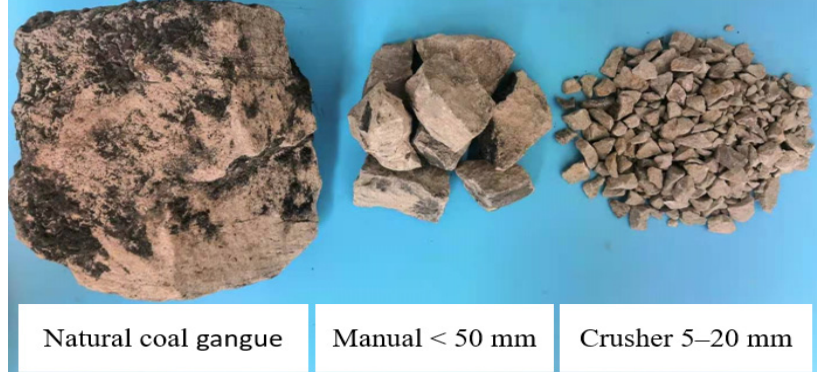
Figure 2. The production process of gangue coarse aggregate (GA). Table 1. The mixes and mechanical properties of concrete.